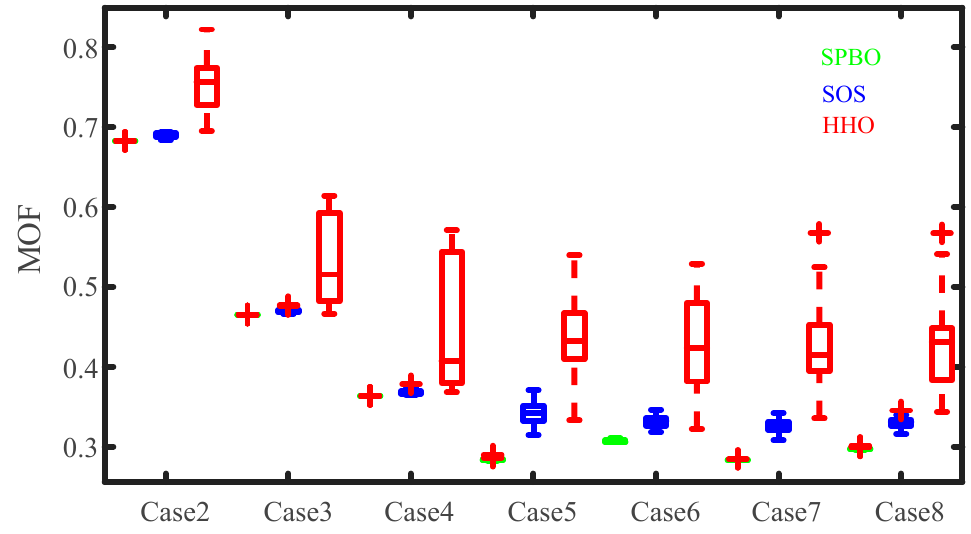
Figure 11. Box plots for 118-node test system.